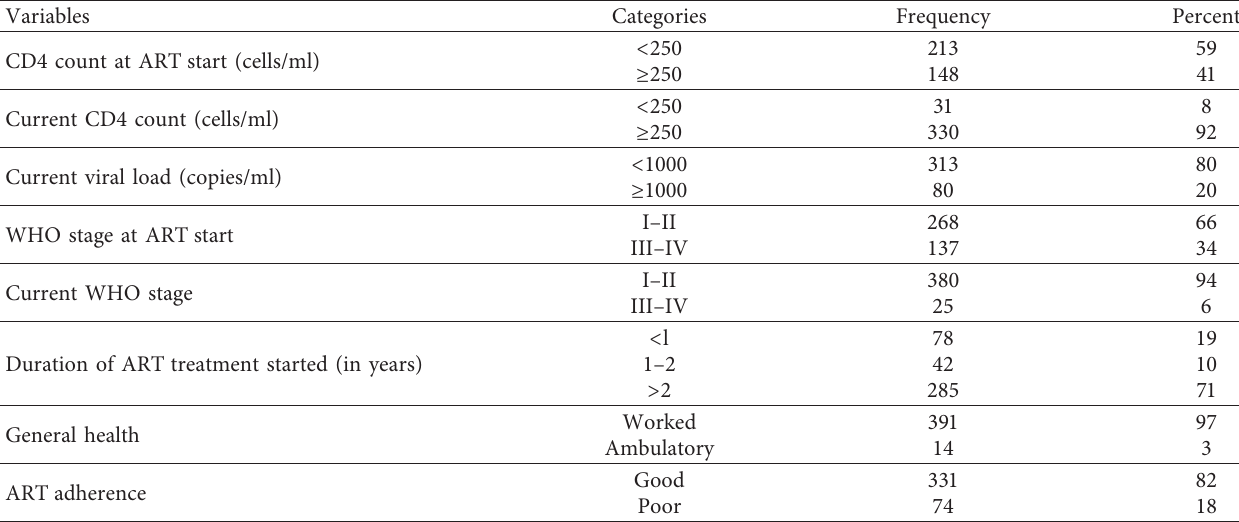
Table 2: Individual and disease-related factors of ARTpatients attending public health facilities of Butajira town, Southern Ethiopia, 2019 ( n � 405).